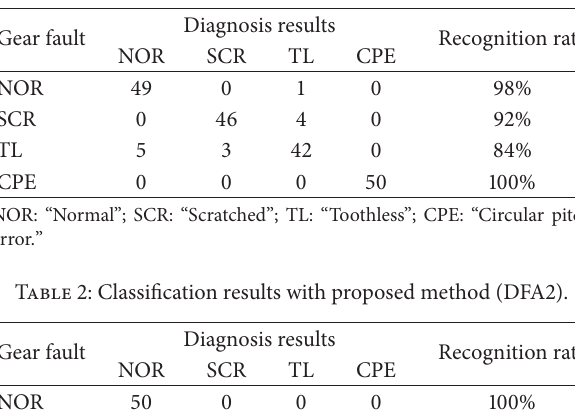
Table 1: Classification results with proposed method (DFA1).